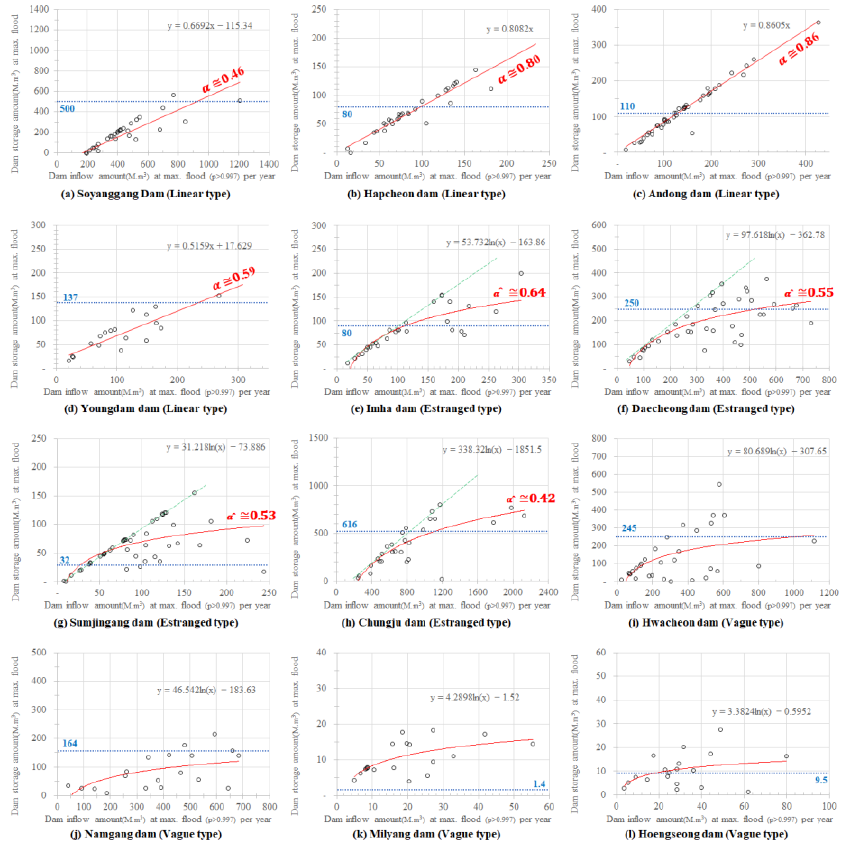
Figure 4. Scatter plot of RSF values of each dam for ( a ) Soyanggang, ( b ) Hapcheon, ( c ) Andong, ( d ) Youngdam, ( e ) Imha, ( f ) Daecheong, ( g ) Sumjingang, ( h ) Chungju, ( i ) Hwacheon, ( j ) Namgang, ( k ) Milyang, ( l ) Heongseong; each point indicates RSF value for every year; red line indicates regression line of RSF points; α indicate the RSF value with linear regression line and ˆ a indicate mean RSF value for logarithmic type; blue dot–lines indicate flood control capacity; green dot–lines denote the high threshold of RSF for ( e ) to ( h